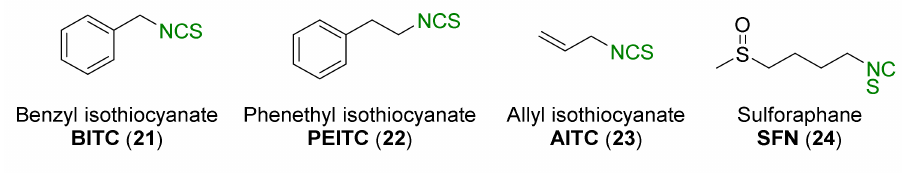
Figure 4. Structures of selected natural